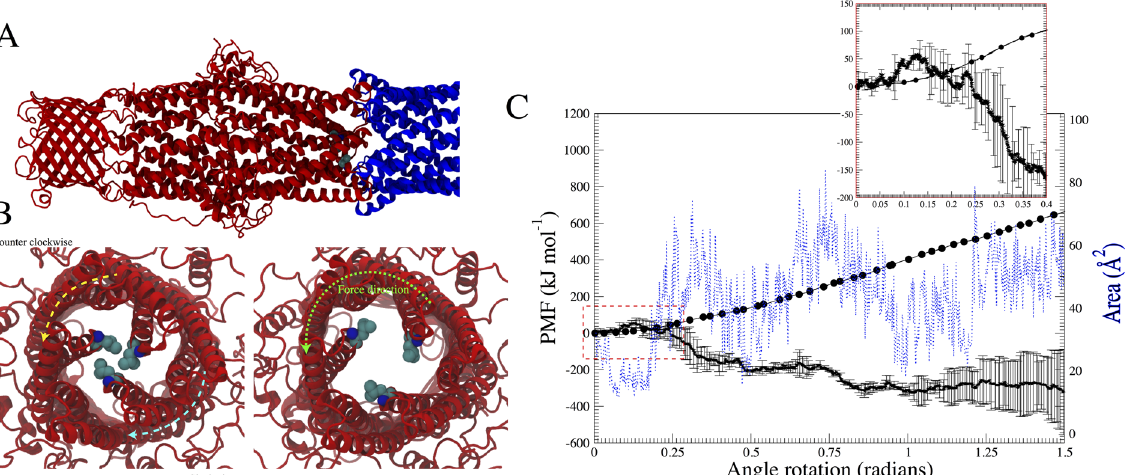
Figure 7. Enforced rotational aperture opening of OprM. ( A ) System set-up highlighting the OprM domain (red ribbons) and the periplasmic protein helices (blue ribbons). The rotational force was applied to the periplasmic protein component. ( B ) Different directions of the force applied in respect to the periplasmic tips in the OprM domain. The counter clockwise rotation is featured by the increase of the area enclosed by the Leu429 (see Results). ( C ) Potential of mean force (PMF) as a function of rotated angle (radians) in the periplasmic domain MexA. Cumulative energy for the counter-clockwise rotation is shown as a black solid line. The small inset highlights the unfavorable process within the first 0.15 radians and is characterized by an increase of ~50 kJ mol − 1 . The rotation becomes favorable after 0.25 radians and is featured by a constant increase of the aperture area (dashed blue line) as shown in the right axis. The clockwise rotation, however, is not favorable as shown by the constant increase in energy with increased rotation angle (black dotted